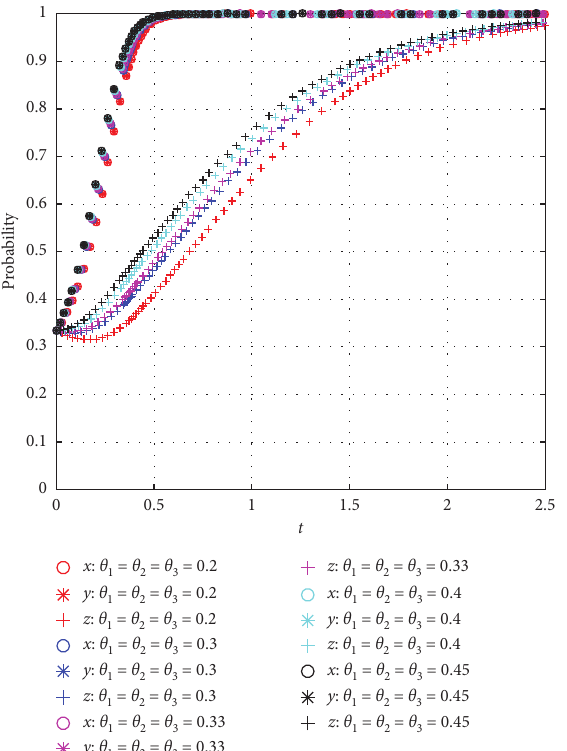
Figure 10: Evolution paths of scenario 4 under different residual benefit